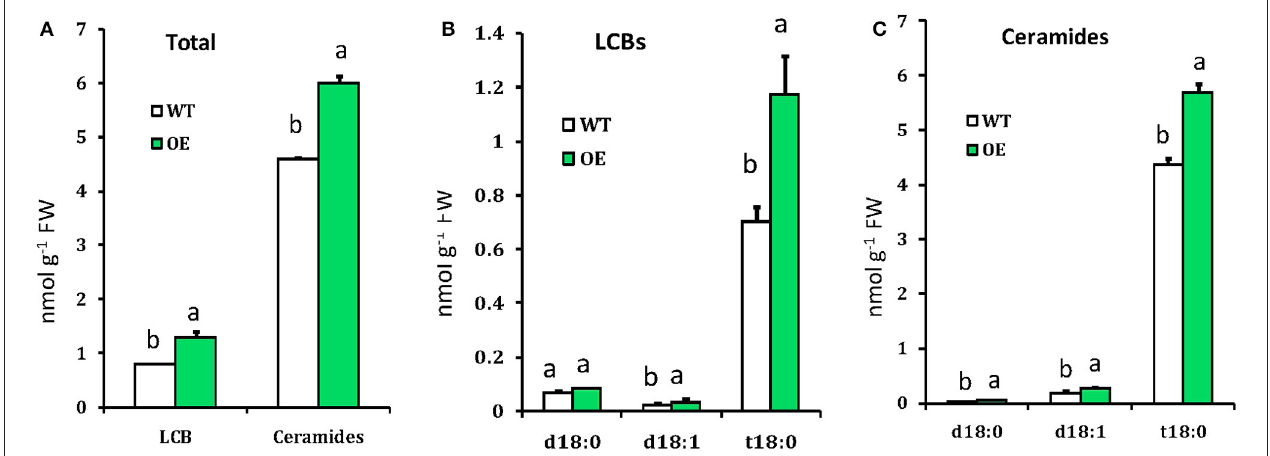
FIGURE 3 | Measurement of sphingolipids in WT and OE plants. (A) Total LCBs and ceramides in indicating plants. (B) Free LCBs composition. (C) LCB moiety distribution of ceramide species. Values represent means ± SE from three independent experiments. Different letters indicate significant differences ( P < 0.05) between the